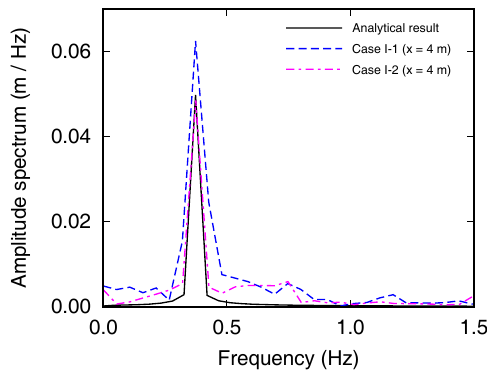
Figure 4. Comparison of the numerical wave at x = 4.0 m in the frequency domain.